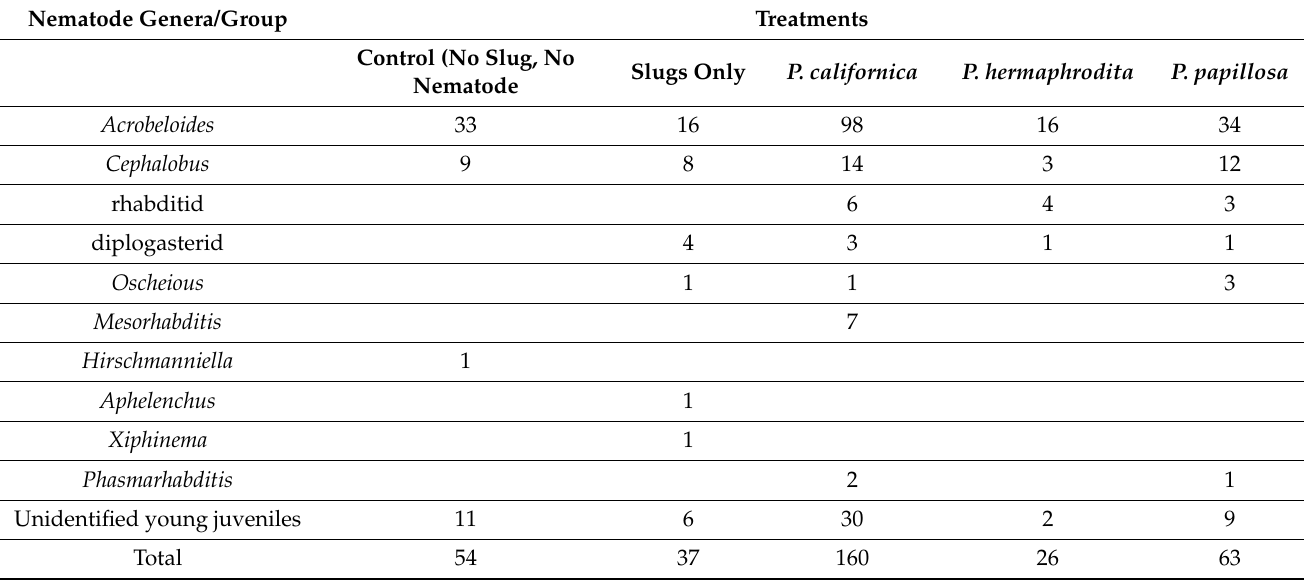
Table 1. Nematode recovery from soil (38 g) extracted from arenas, three weeks after treatment application. Lath house experiment 3, April